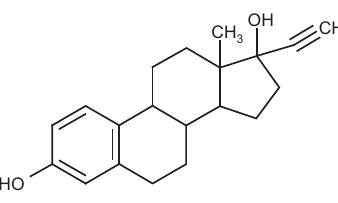
Figure 1 Structure of ethinyl estradiol.